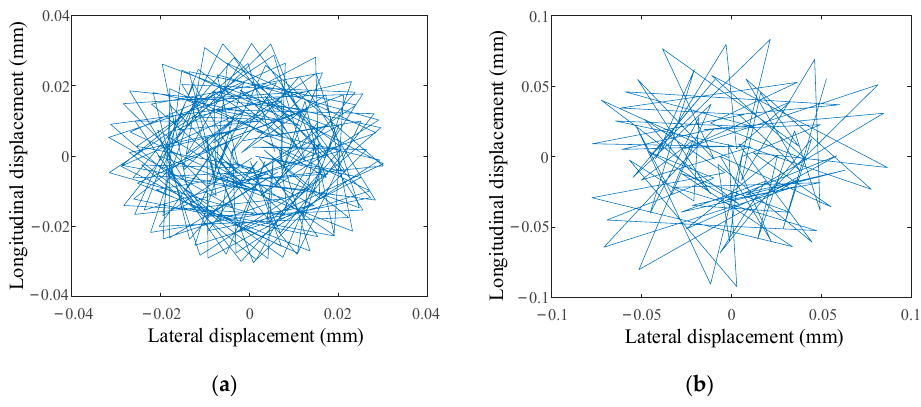
Figure 5. Floating displacement of the sun gear. ( a ) The second stage; ( b ) the third stage.